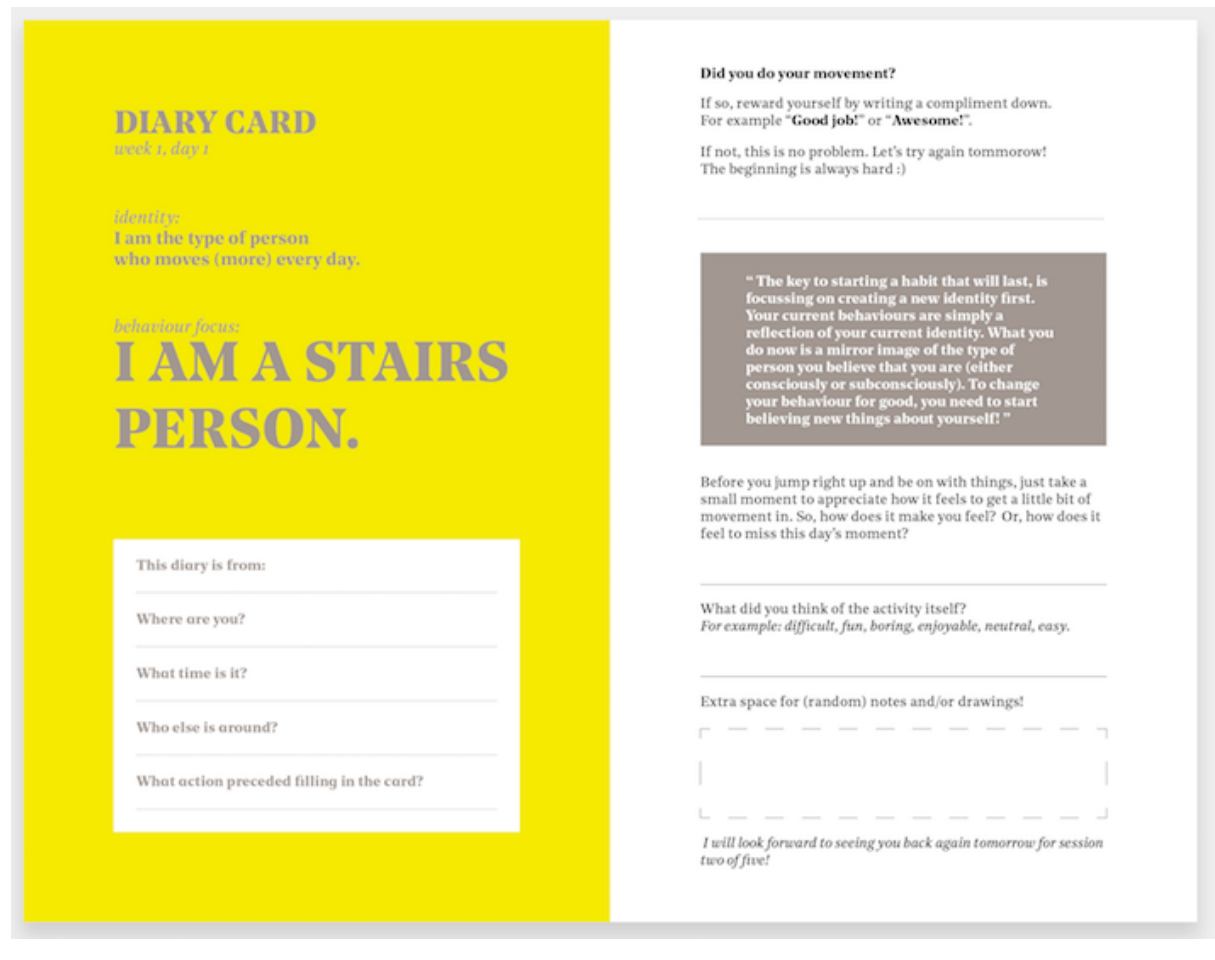
Figure 3. Example of the diary cards used in week